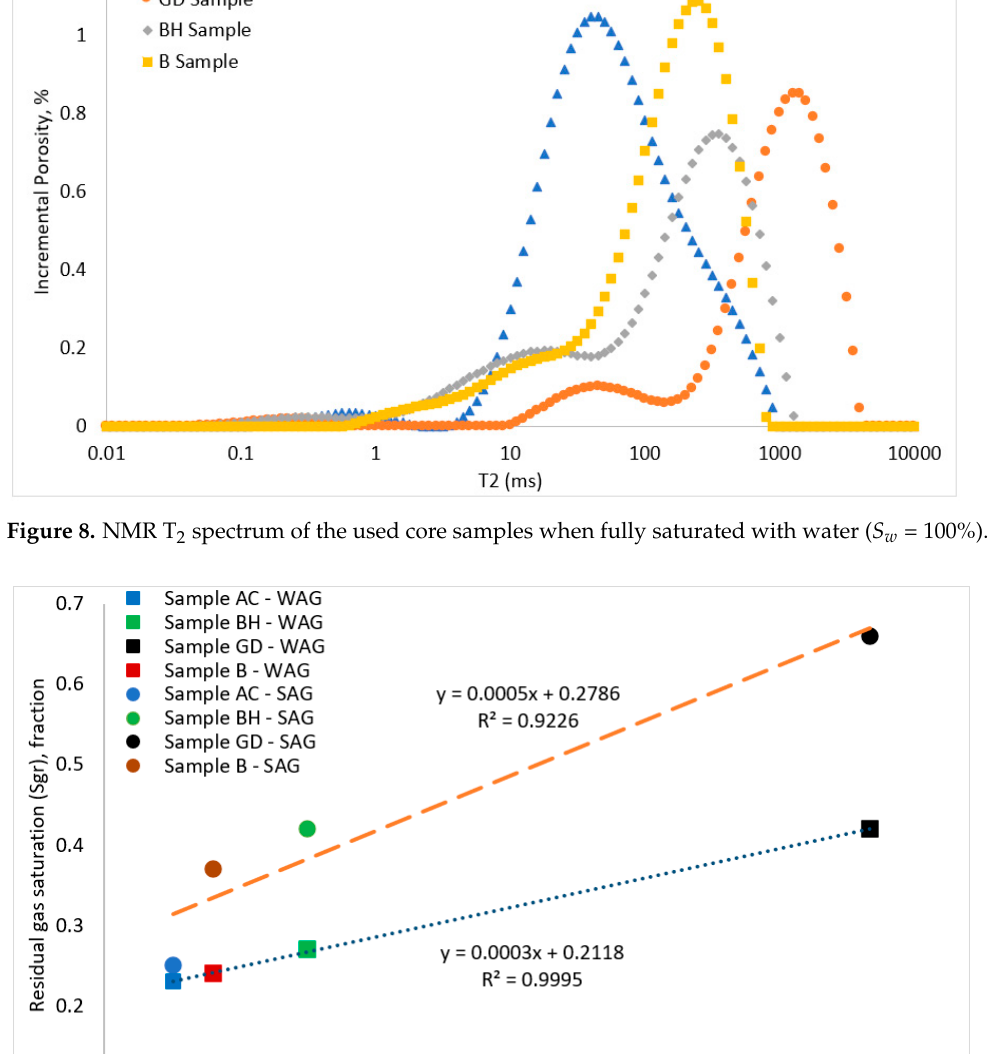
Table 3. Correlations of residual gas saturations versus T 2 log mean value .